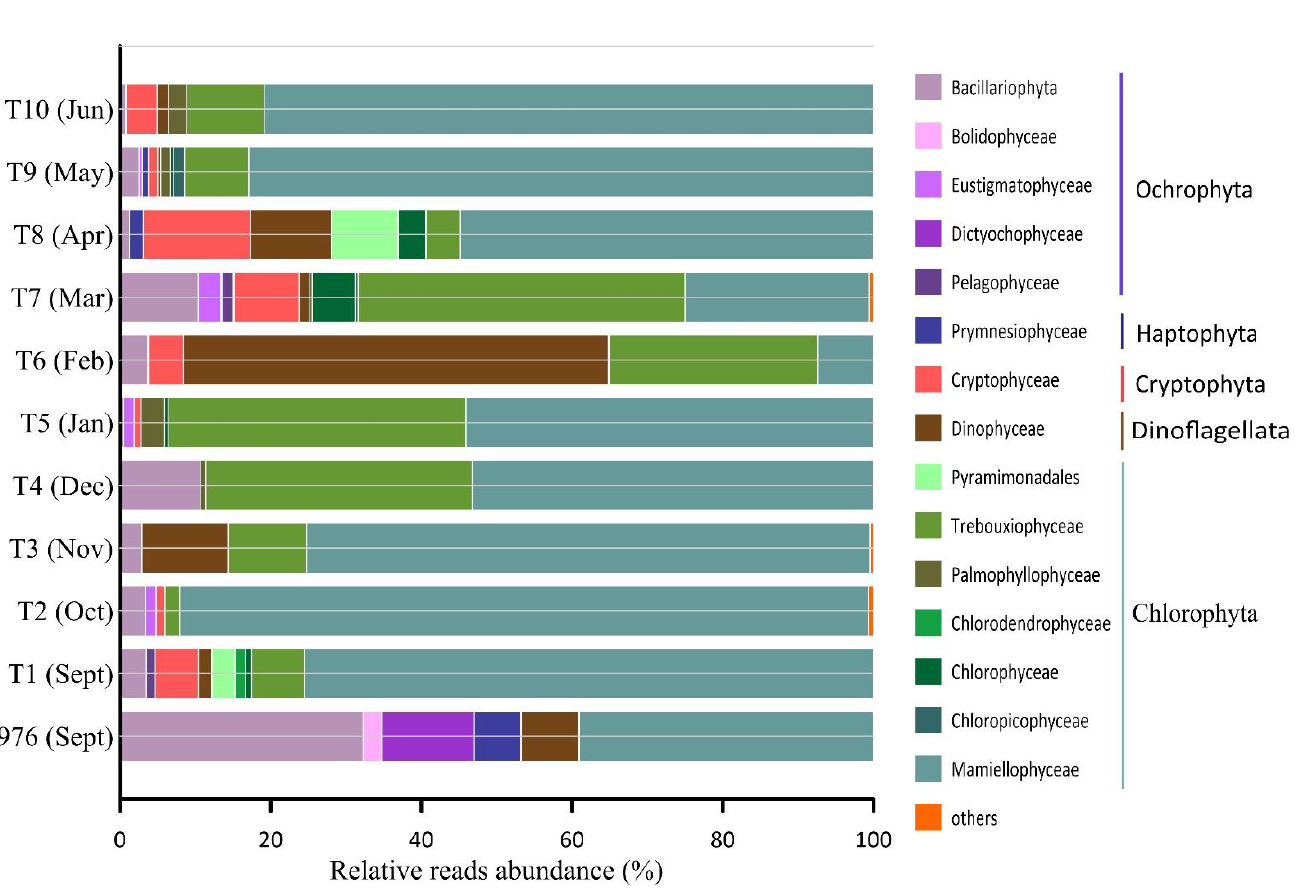
Figure 6. Relative reads abundance (%) of different PE groups in the studied samples. “Others” includes groups with the contribution <1% (Pycnococcaceae_X_sp., Prasino-Clades, Chrysophyceae).